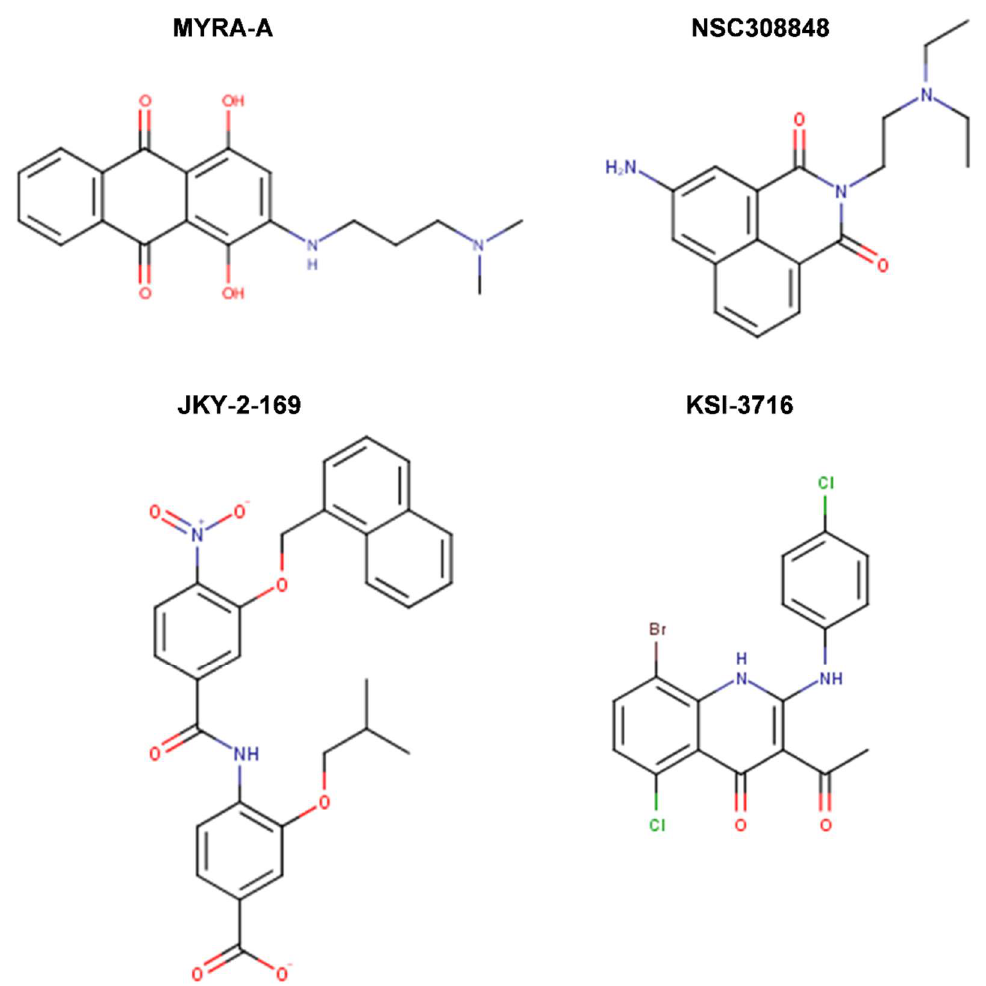
Figure 8. Chemical structures of MYRA-A, NSC308848, JKY-2-169, and KSI-3716 inhibitors of Myc-Max binding to DNA identified through high-throughput screening or specifically engineered to disrupt protein-DNA interactions. See text for details.